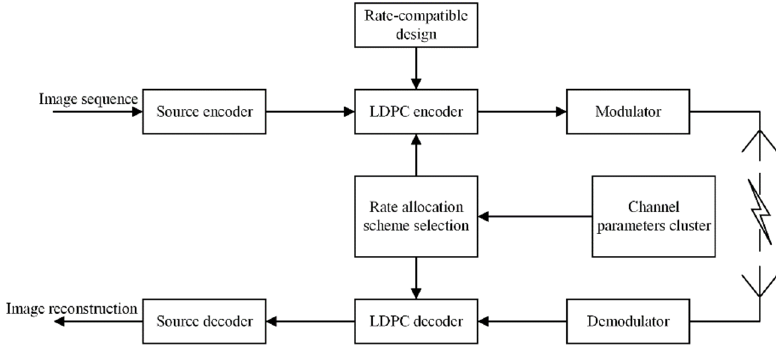
Figure 20. The adaptive RC-LDPC coding scheme block diagram.